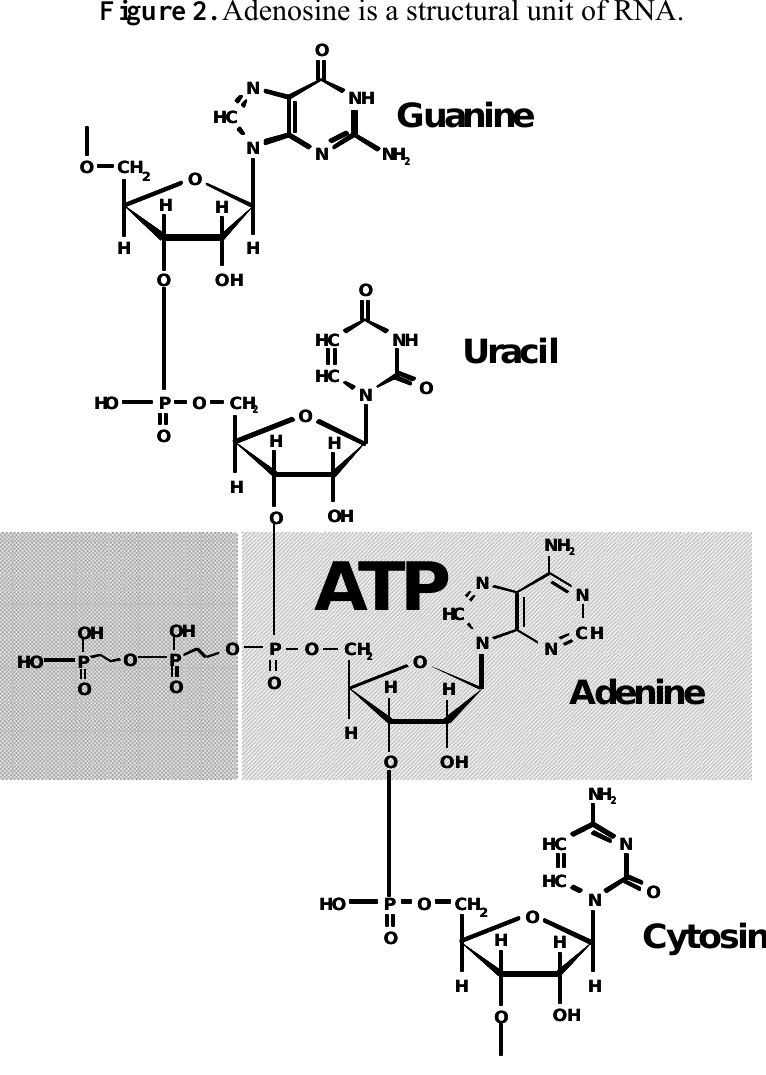
Figure 2. Adenosine is a structural unit of